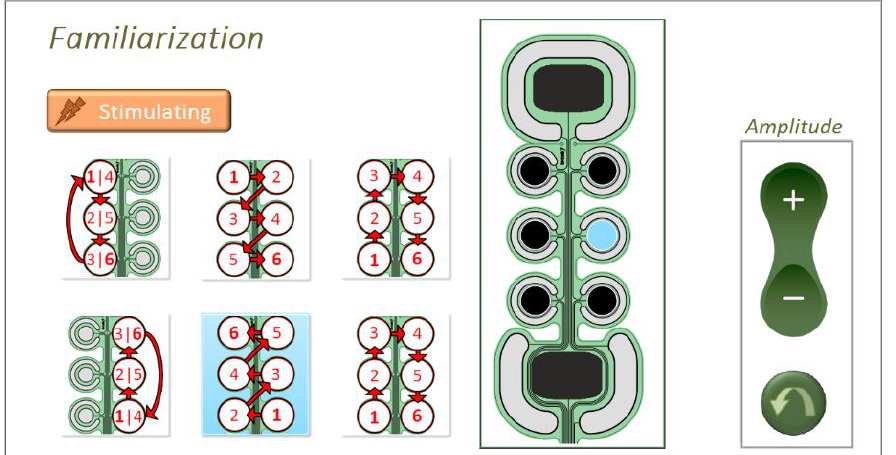
Figure 2. Familiarization phase during the pattern recognition test. Active pattern with activation order ( left ) and currently active pad ( middle ) are highlighted on the screen in blue color. This is the GUI seen by the subjects and the controls in the amplitude box were used to adjust the stimulation intensity, as described in the text.